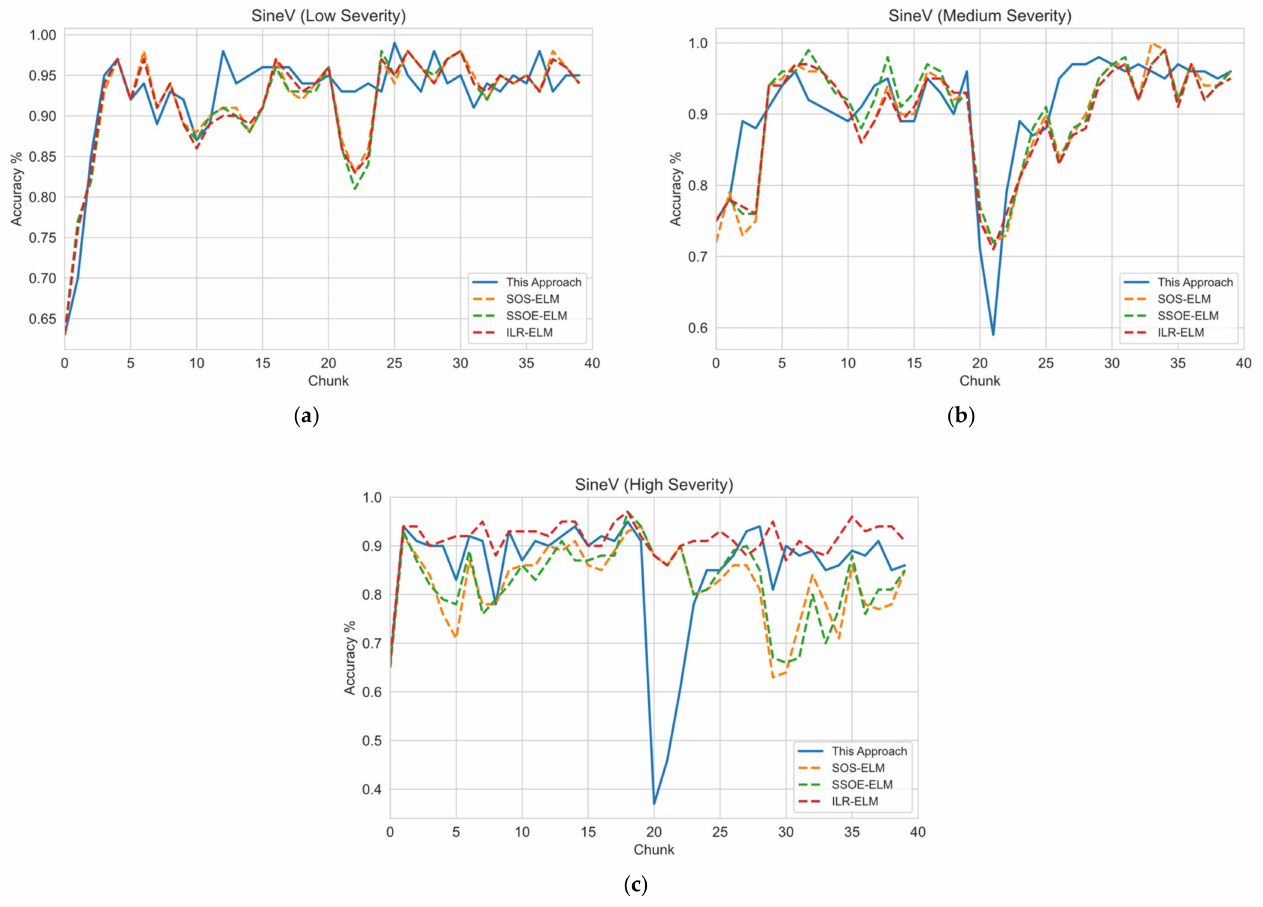
Figure 4. SineV dataset experiment on variable concept drift severity. ( a ) Performance on low severity dataset. ( b ) Performance on medium severity dataset. ( c ) Performance on high severity